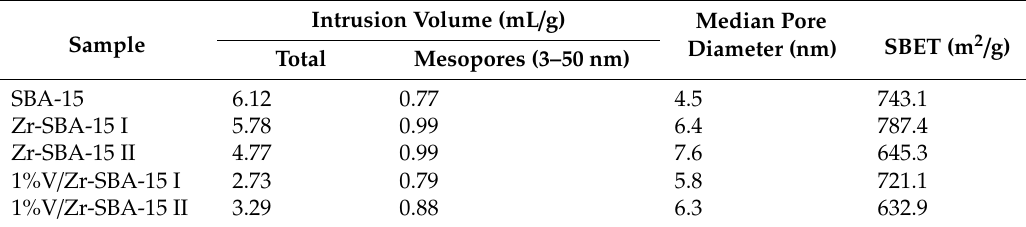
Table 2. Textural properties of fresh support and